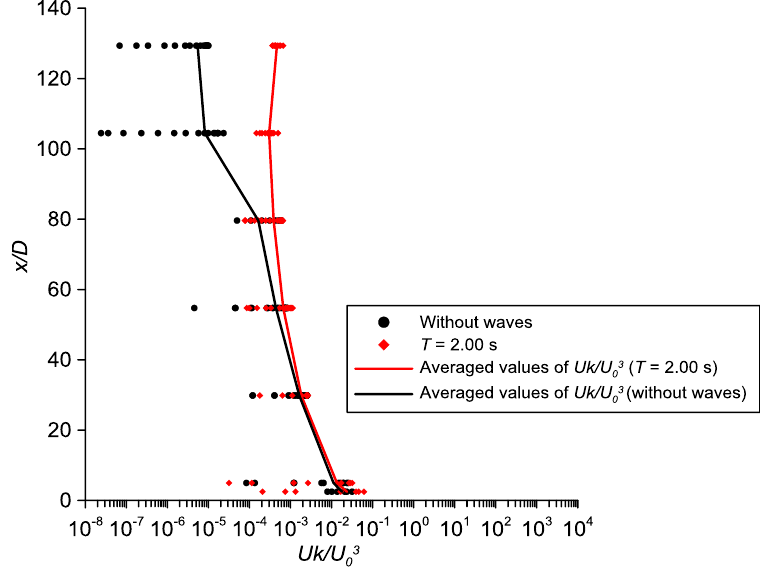
Figure 14. Values of K xx of Run 1 of Table 1 and of the same jet without waves with lines of the averaged values of each cross section.